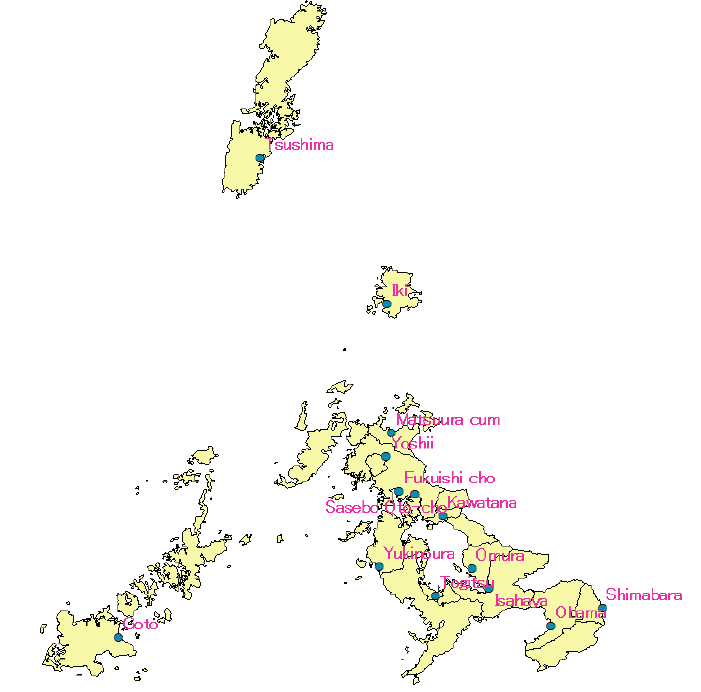
Figure 2. PM 2.5 monitoring stations in Nagasaki